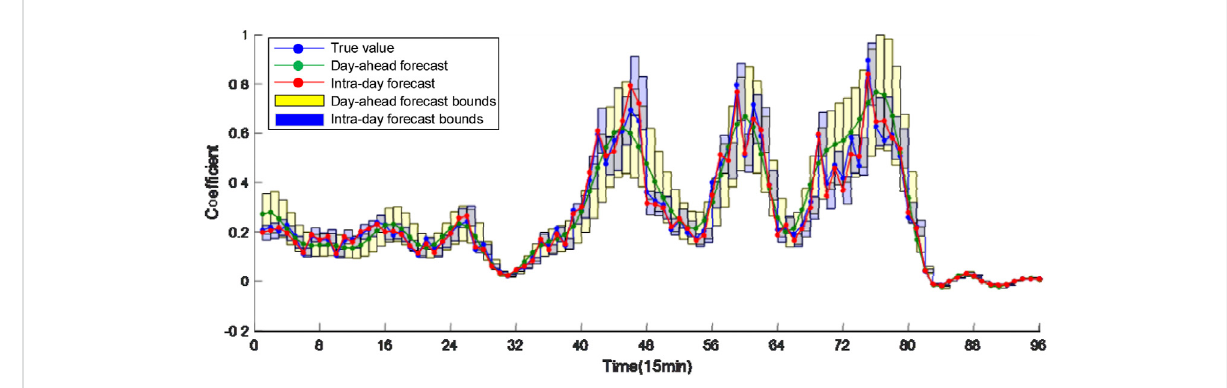
FIGURE 8 Day-ahead and intro-day forecasting curves of charging load.